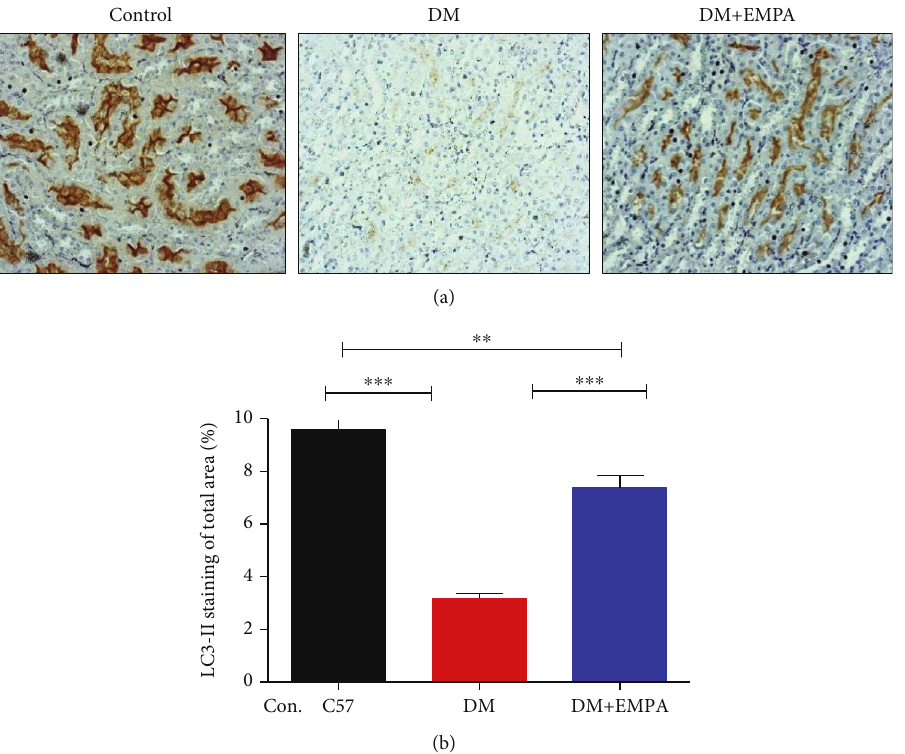
Figure 6: (a) Representative IHC staining of LC3-II in mice renal sections (magni fi cation × 20). (b) Quanti fi cation of total LC3-II expression-renal LC3-II was signi fi cantly decreased in DM mice compared with c57/Bl mice. Higher than DM and similar to C57/Bl level, the expression of LC3-II was observed in DM+EMPA mice compared with DM